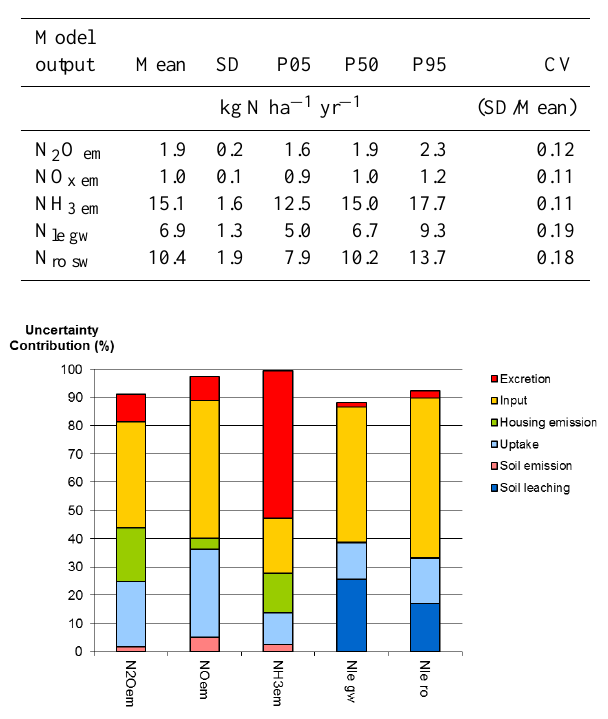
Fig. 6. Relative uncertainty contributions of individual model input Figure 6 Relative uncertainty contributions of individual model input groups (CV in %) to 2 groups (CV in %) to N 2 O emission, NH 3 emission, N leaching to N 2 O emission, NH 3 emission, N leaching to groundwater and N runoff to surface water for 3 groundwater and N runoff to surface water for the EU27 for the year the EU27 for the year 2000. 4